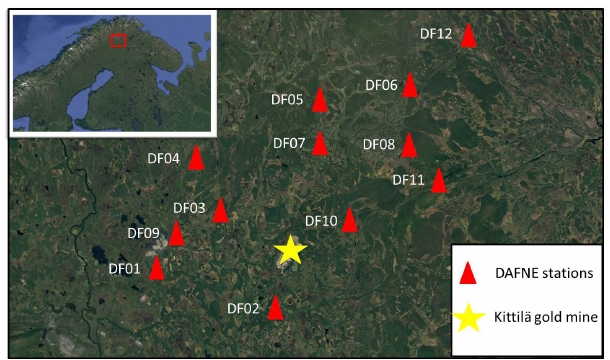
Figure 1. Position of the DAFNE temporary array on the geograph- ical map.